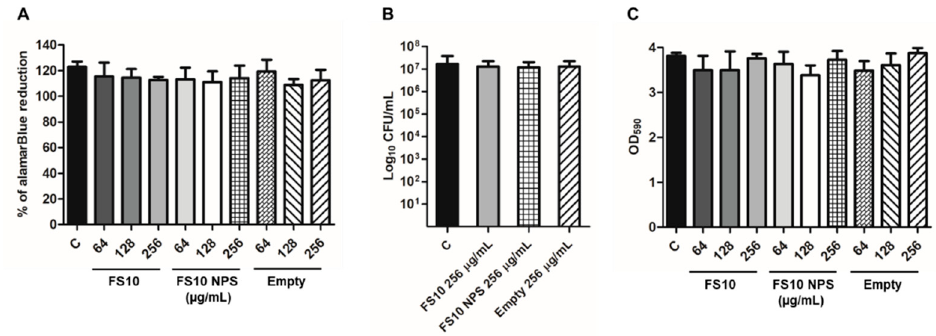
Figure 9. Determination of the MBIC of FS10, FS10-loaded-Nps, and empty Nps through the ala- marBlue assay ( A ), the CFU count ( B ), and the Crystal Violet assay ( C ). C, control biofilm. The results represent the mean of two independent experiments performed in triplicate. C (ANOVA + Dunnet’s Multiple comparison test).